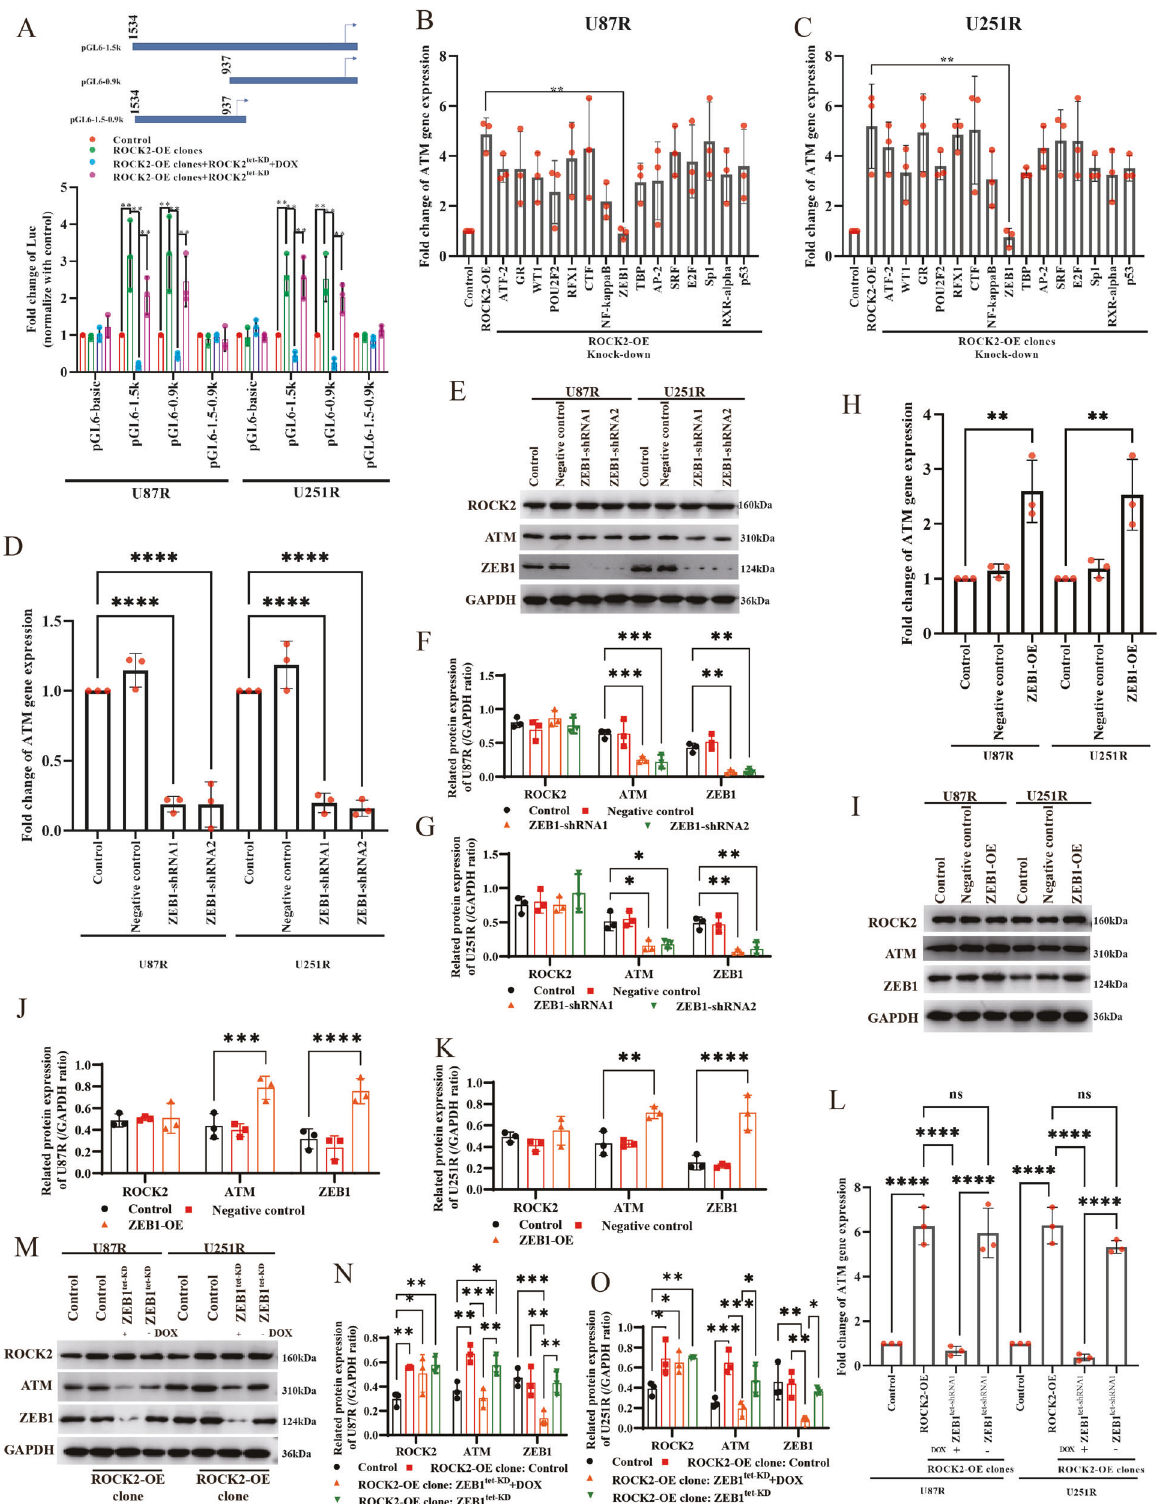
Fig. 7 ROCK2 mediated ATM expression via ZEB1. A Different wild-type ATM promoter luciferase reporter constructs were used for binding assay. B , C ATM gene expression of U87R and U251R was determined with different siRNA of TFs as indicated. D ATM gene expression was determined with ZEB1 knock-down. E – G ATM protein expression was determined with ZEB1 knock-down. WB results: E , Quanti fi cation of WB: F and G . H ATM gene expression was determined with ZEB1 overexpression. I – K ATM protein expression was determined with ZEB1 overexpression. WB results: I , Quanti fi cation of WB: J and K . L ATM gene expression was determined with ZEB1-tet-KD in ROCK2-OE cells. M – O ATM gene expression was determined with ZEB1-tet-KD in ROCK2-OE cells. WB results: M , Quanti fi cation of WB: N and O . Data are shown as of three independent experiments. p values determined by ANOVA or two-tailed unpaired t -test. Statistical differences compared with the controls are given as * p < 0.05, ** p < 0.01, *** p < 0.005, **** p < 0.001. Cell Death and Disease (2022)